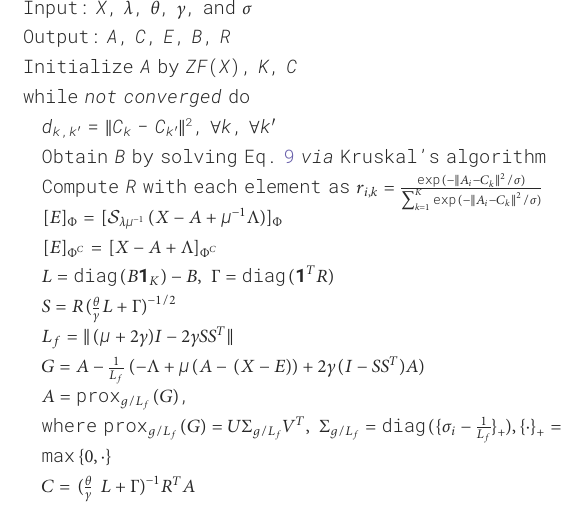
Algorithm 4. The inexact RobustTree